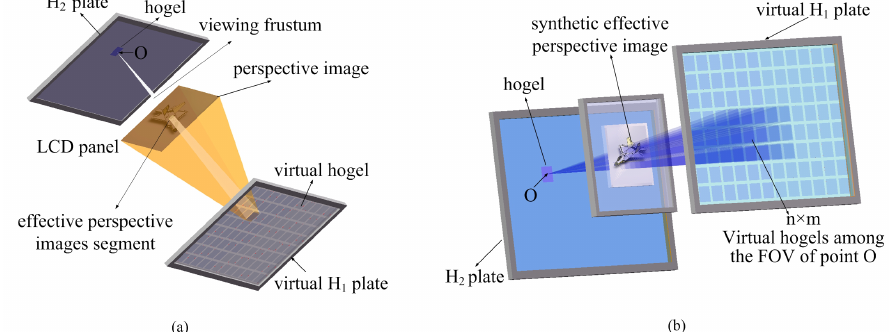
Figure 2. The primitive principle of the proposed method. ( a ) The extraction of effective perspective image segment corresponding to a single virtual hogel. ( b ) The synthetic effective perspective image mosaicked by effective images segments of multiple virtual